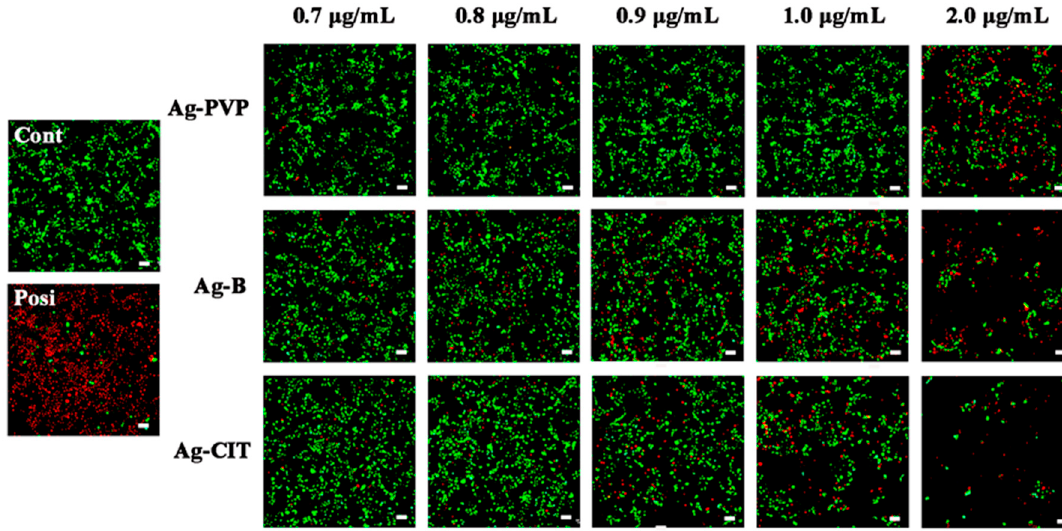
Figure 3. The representative live/dead staining images of Caco-2 cells after being exposed to three Ag NPs with different concentrations for 24 h. The positive control was prepared by treating normal cells with 200 mM H 2 O 2 for 10 min. Scale bar: 60 μ m.